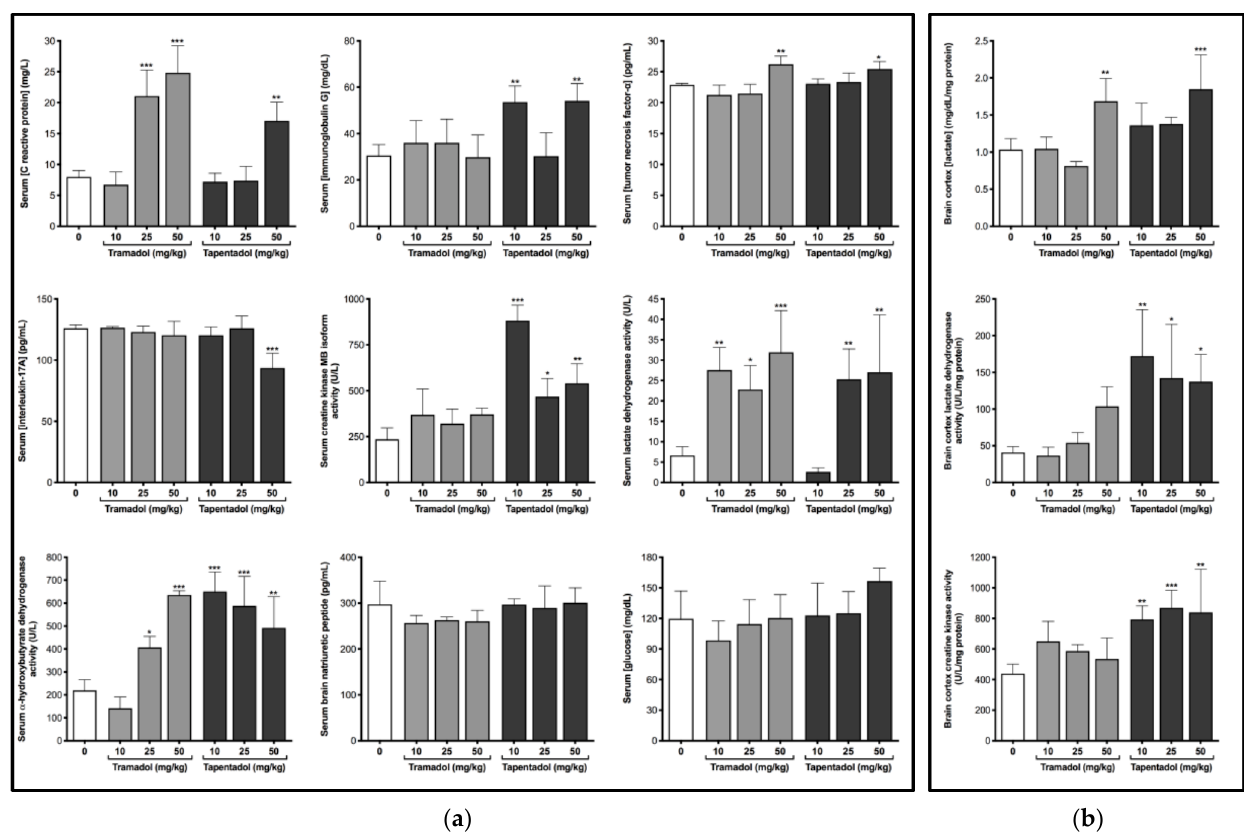
Figure 2. Concentrations of serum immunological, inflammatory, cardiac and metabolic biomarkers ( a ), as well as tissue biochemical parameters concerning brain cortex metabolism ( b ), upon Wistar rat repeated daily intraperitoneal (i.p.) administration of 10, 25, or 50 mg/kg tramadol or tapentadol, for 14 consecutive days. Results are expressed as means ± SD. *** p < 0.001, ** p < 0.01, * p <